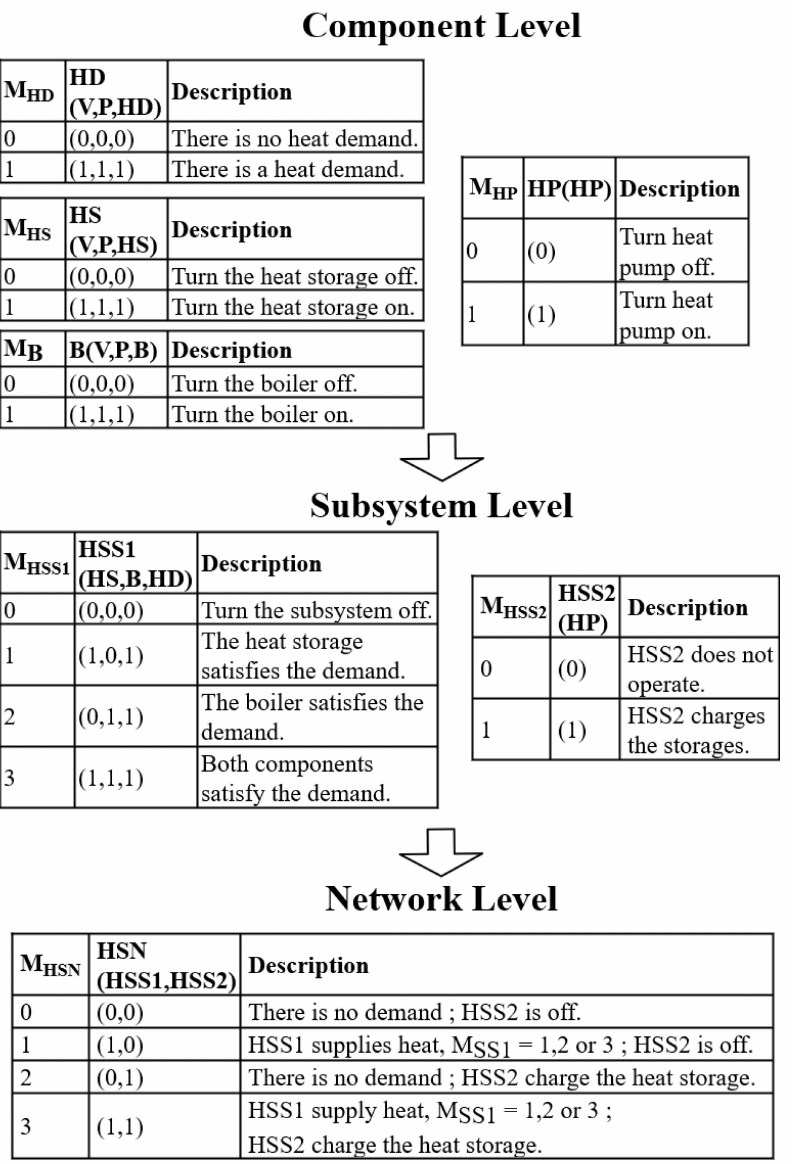
Figure 7. The aggregation of the permissible operating modes of the heat supply network. HSN: heat supply network; HSS: Heat supply subsystem; HP: heat pump; HS: Heat storage; B: Boiler; HD: heat demand; V: valve; P: